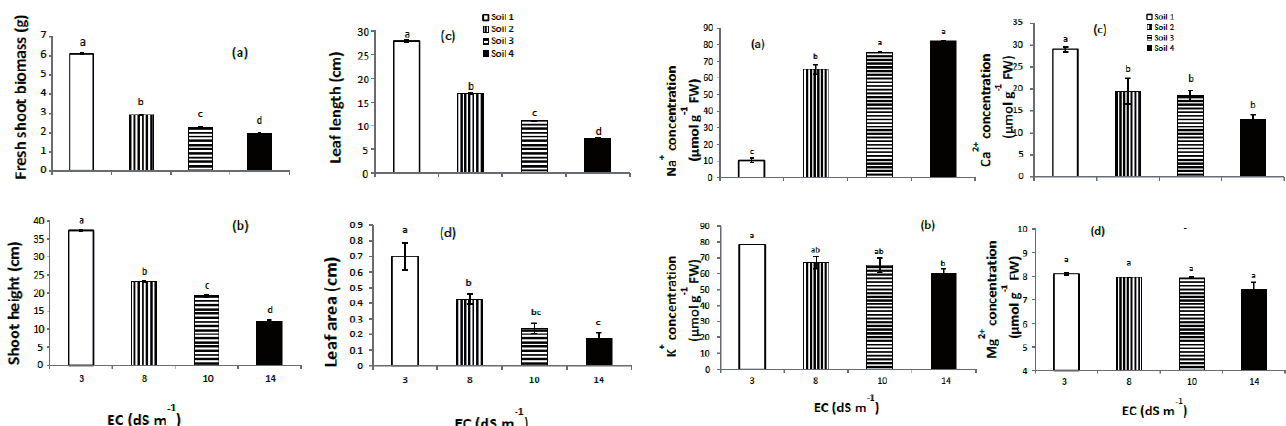
Fig. 2: Effect of various EC level of the soil samples (on X axis) on Na + concentration μmol g -1 FW (a), K + concentration μmol g -1 FW (b), Ca 2+ concentration μmol g -1 FW (c), and Mg 2+ concentration μmol g -1 FW (d), in the total shoot of maize plants. Different letters indicate significant differences between the treatments at P < 0.05 (n ≥